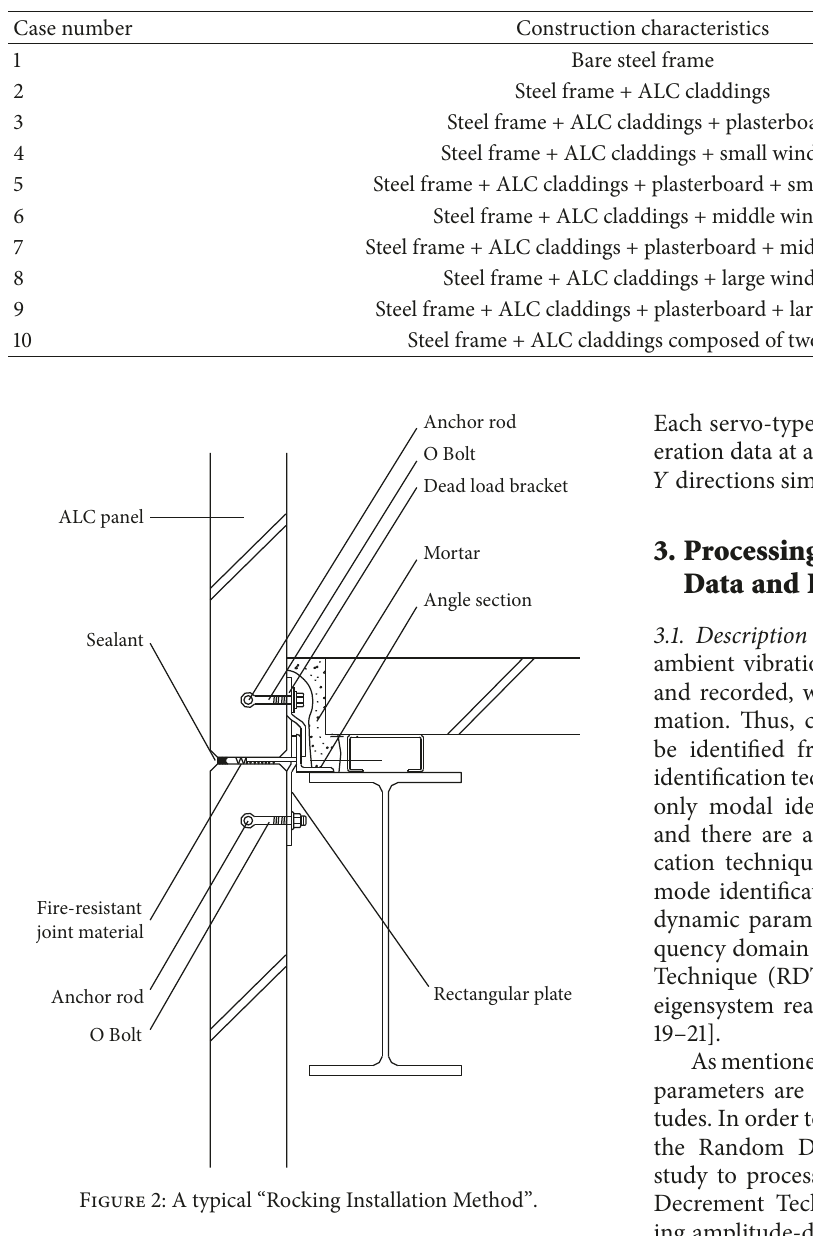
Table 2: Summary of test cases.